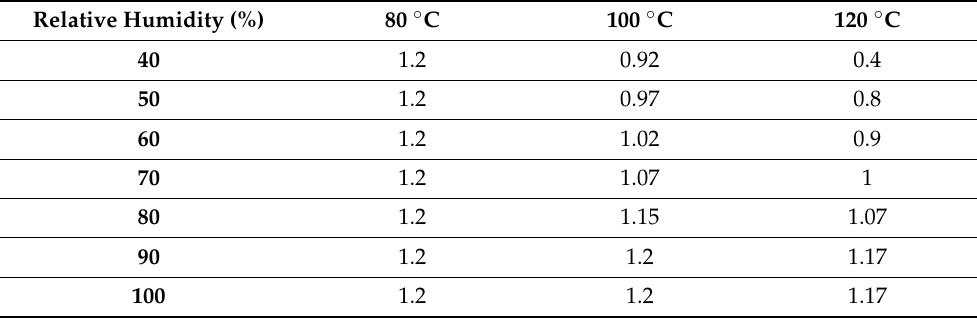
Table 7. The fitted water activity used in the model for each relative humidity and temperature. Relative Humidity (%)